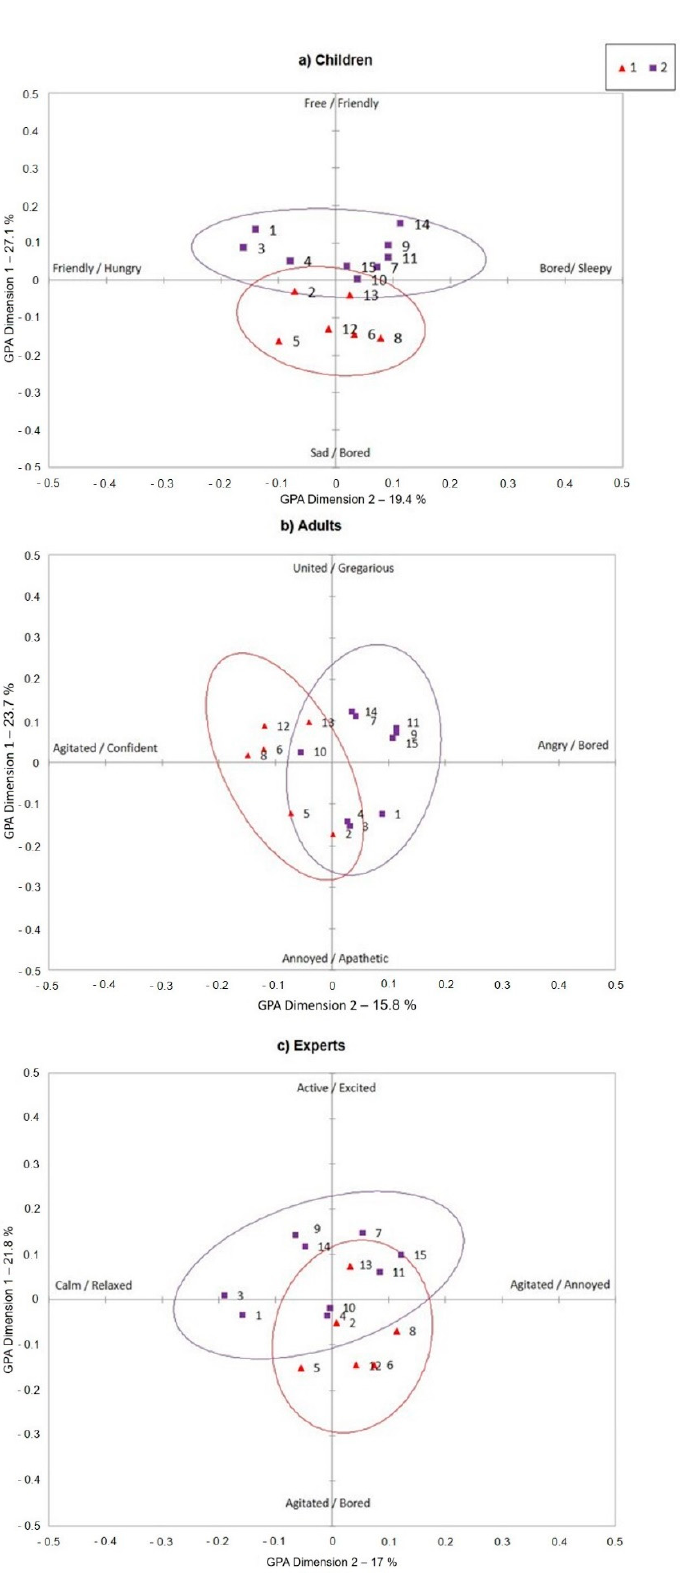
Figure 3. Generalized Procrustes Analysis (GPA) consensus score—elephant video scatter plots. The scatter plots represent the distribution of the videos (represented by the 1–15 numbers) on dimensions 1 and 2 of the consensus profile for ( a ) children, ( b ) adults, and ( c ) experts and the separation between videos representing captive (red triangles) and semi-captive (purple